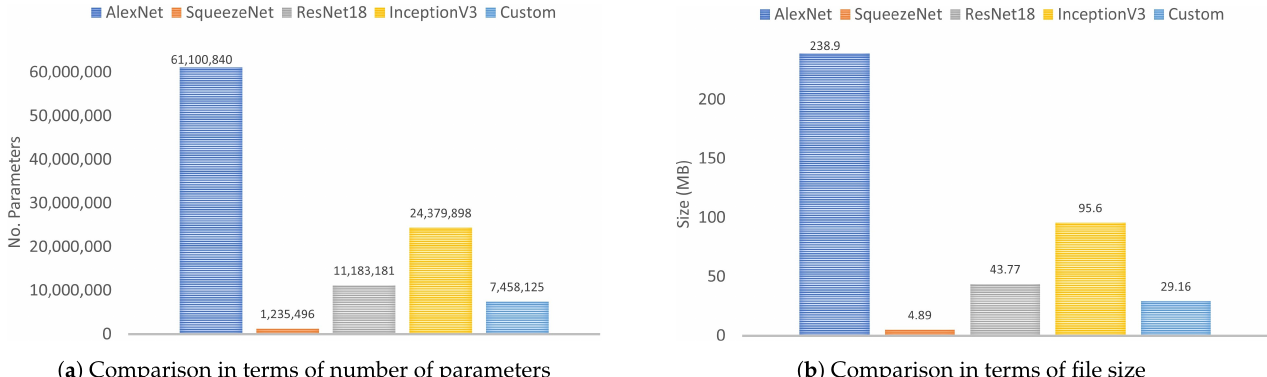
Figure 19. Comparison of the custom model and the four TL-based models in terms of number of parameters and in terms of file size.